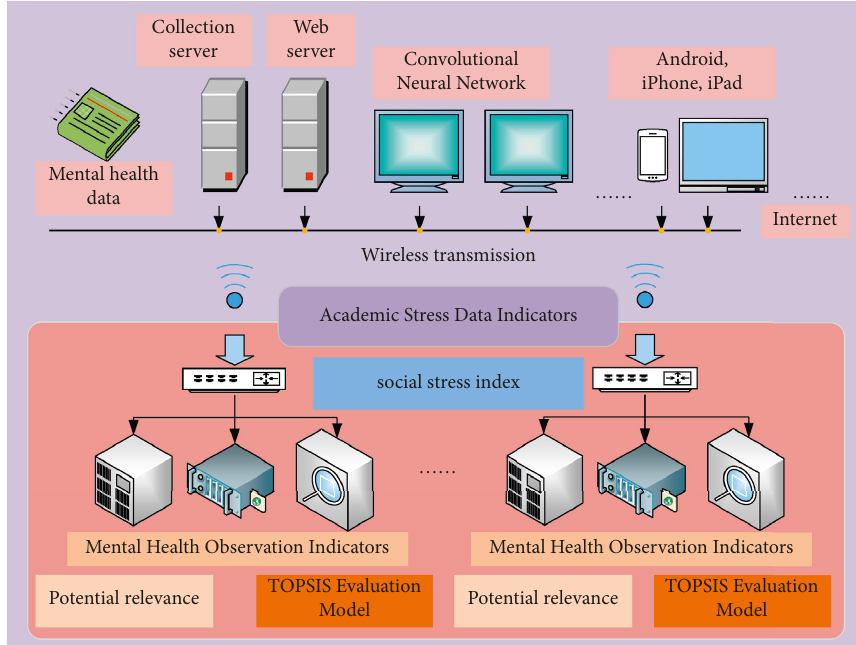
Figure 1: Processing and analysis of the mental health data of college students using convolutional neural networks. Mental health data entry